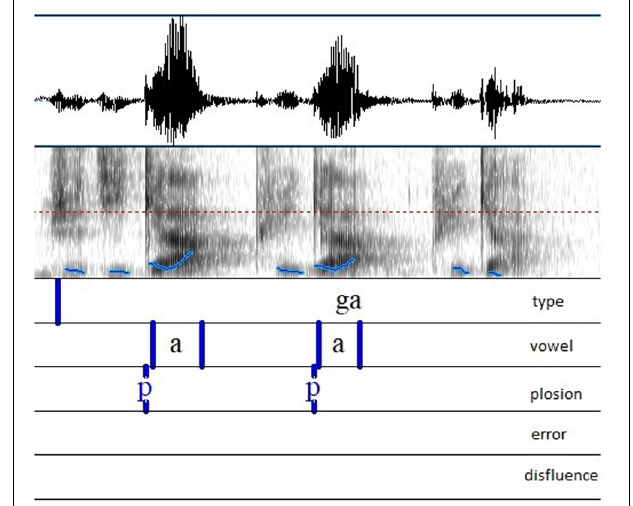
FIGURE 2 | Example of annotation: /ga/.